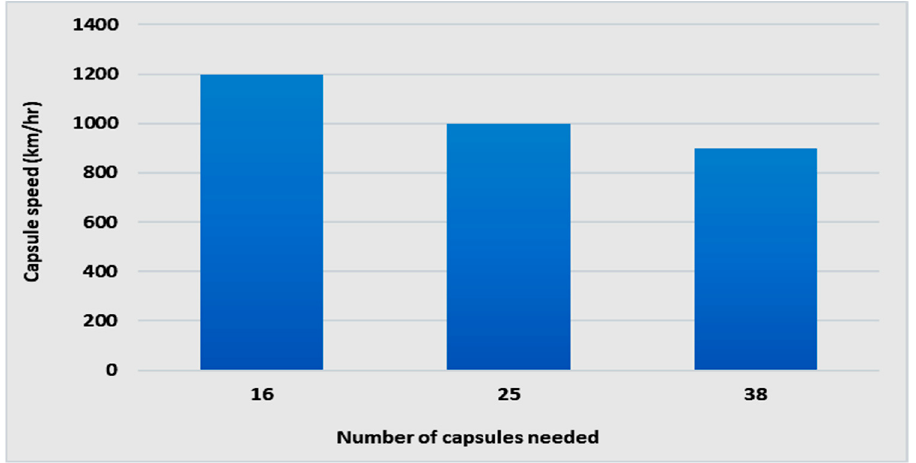
Figure 5. The number of capsules needed under alternative speed assumptions.